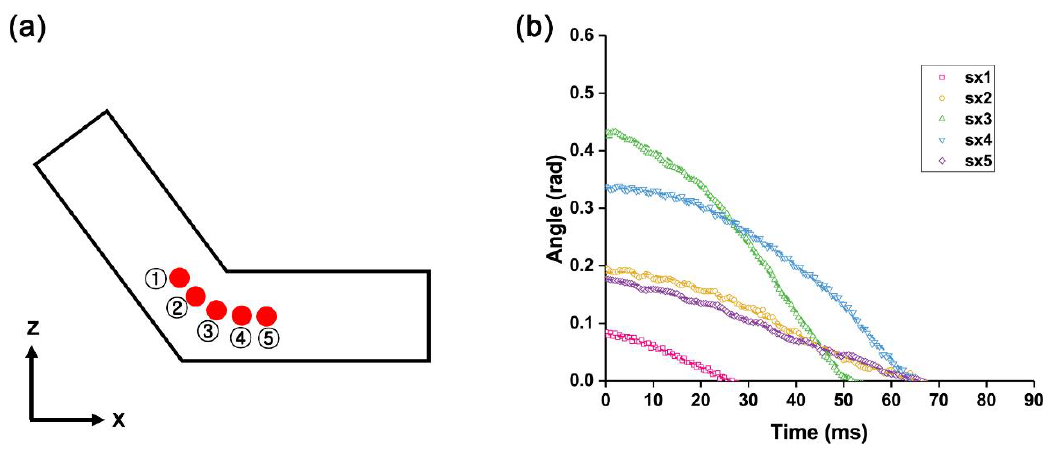
Figure 6. Angle changes with panel rotation axis position x p variation. ( a ) Positions of rotational axis are marked with number. The number ③ is center of the two panels. ( b ) The angles of motion are tracked in real time owing to the position of the changes in the driving shaft.